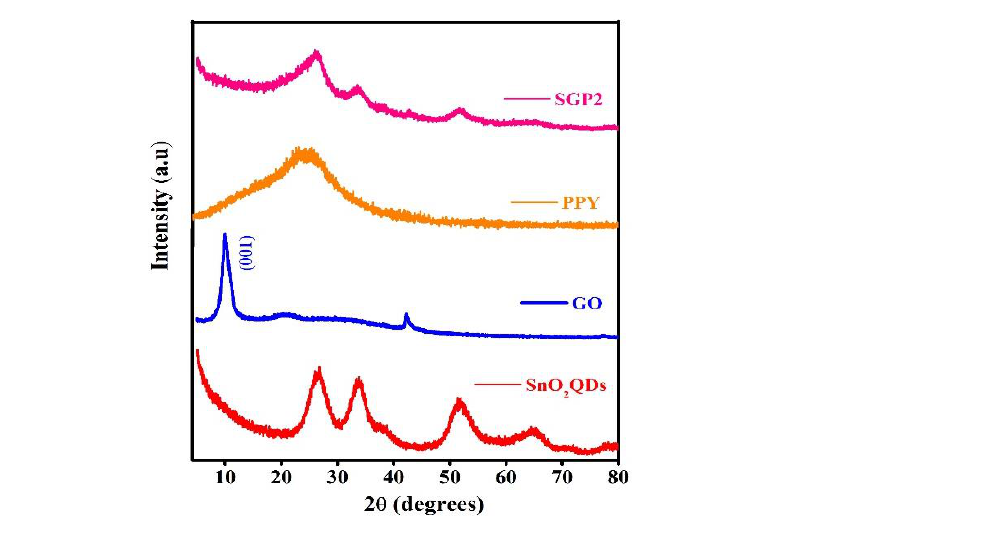
Figure 2. X-ray diffraction (XRD) patterns for the SnO 2 QDs, PPy, GO, and SnO 2 QDs/GO/PPy composites .